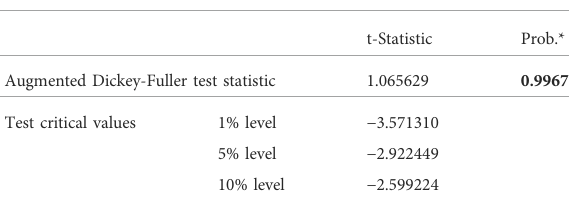
TABLE 2 The unit root test of fi rst-order difference sequence.